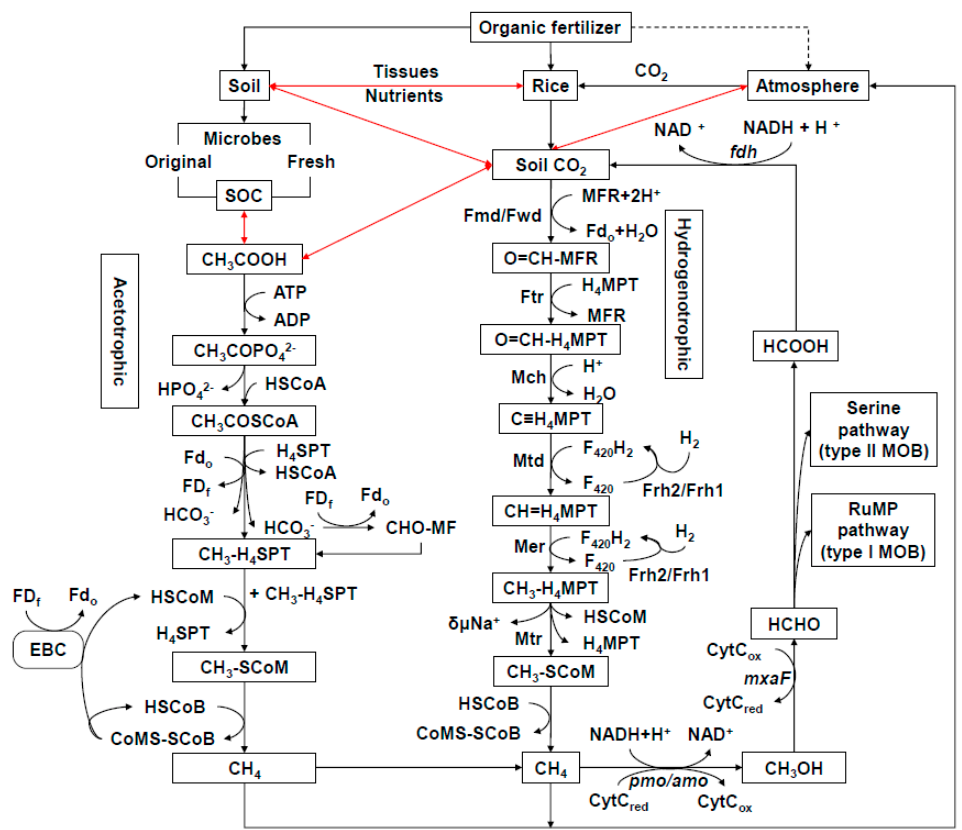
Figure 1. Effects of organic fertilizer on the pathway of CH 4 emission from rice soil. The black lines indicate a transformed direction. The red lines represent bidirections between two matters. The acetoclastic methanogenic pathway was referenced from Soo et al. [17]. SOC, soil organic carbon. CH 3 COOH, acetate. ATP, adenosine triphosphate. ADP, adenosine diphosphate. CH 3 COPO 42- , acetyl phosphate. HPO 42- , hydrogen phosphate ion. HSCoA, coenzyme A. CH 3 COSCoA, acetyl-CoA. Fd o , oxidized ferredoxin. Fd f , reduced ferredoxin. H 4 SPT: 5,6,7,8-tetrahydrosarcinapterin. HCO 3- , bicarbonate ion. CHO-MF, formyl methanofuran. CH 3 -H 4 SPT, methyl-H 4 SPT. HSCoM, coenzyme M. CH 3 -SCoM, methyl-coenzyme M. HSCoB, coenzyme B. CoMS-SCoB, heterodisulfide of coenzyme M and coenzyme B. EBC, electron bifurcating complex. The hydrogenotrophic methanogenic pathway was referenced from Liu et al. [20]. Fmd/Fwd, CHO-MFR dehydrogenase. MFR, methanofuran. Ftr, formyltransferase. H 4 MPT, tetrahydromethanopterin. Mch, methenyl-H 4 MPT cyclohydrolase. Mtd, methylene-H 4 MPT dehydrogenase. F420, coenzyme F420. Frh, reducing hydrogenase. Mer, methylene-H 4 MPT reductase. Na, electrochemical sodium ion potential. Mtr, methyl-H 4 MPT methyltransferase. The methanotrophic pathway was referenced from Cai et al. [22]. NADH/NAD + : Nicotinamide adenine dinucleotide. CH 3 OH: Methanol. HCHO: methanal. HCOOH: methanoic acid. CytC red : Cytochrome C reduction. CytC ox : Cytochrome C oxidation. pmo: methane monooxygenase (particulate). amo: ammonia oxidase. mxaF: methanol dehydrogenase. fdh: formate dehydrogenase. RuMP pathway (type I MOB): phosphoribulose pathway (methanotroph type I). Serine pathway (type II MOB): Serine pathway (methanotroph type